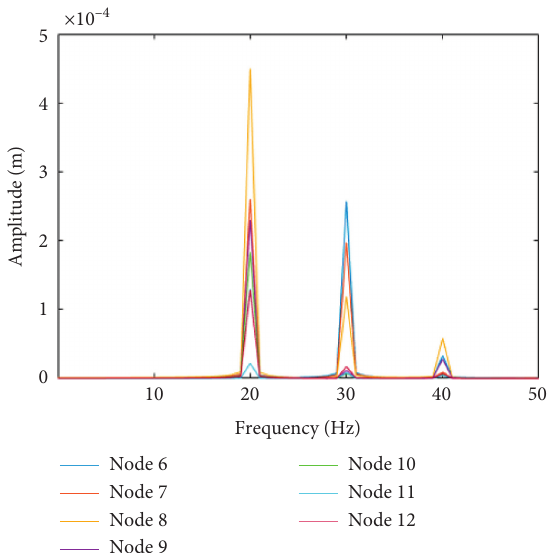
Figure 17: Cylinder I frequency-domain characteristics.